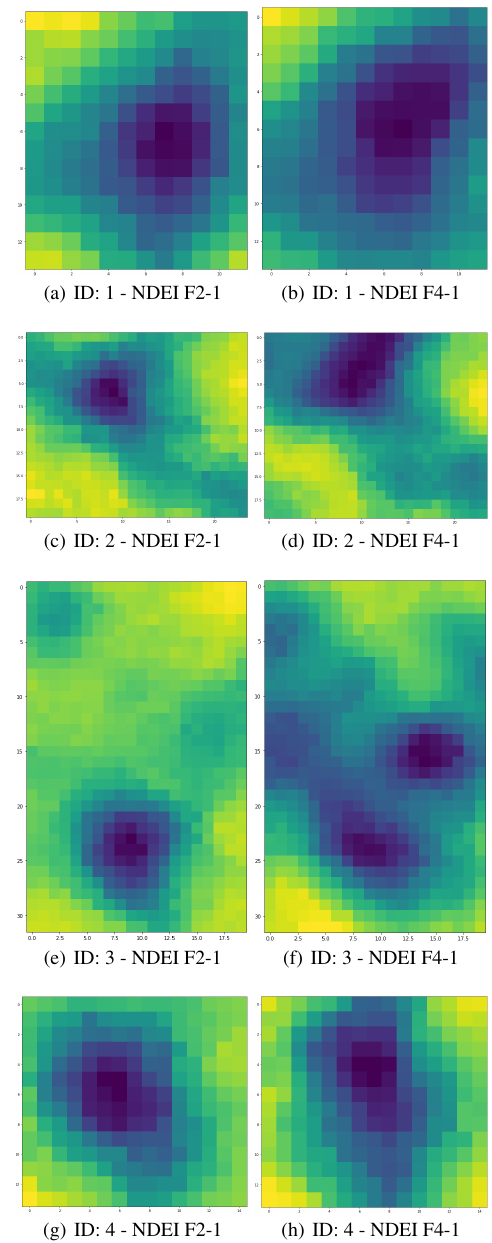
Figure 14. NDEI index corresponding to the areas where the four individual plants were removed (ID denotes each plant identifier; Dark Blue colour represents volume loss change zones with NDEI values close to-1; yellow colour represents no change zones with NDEI values close to